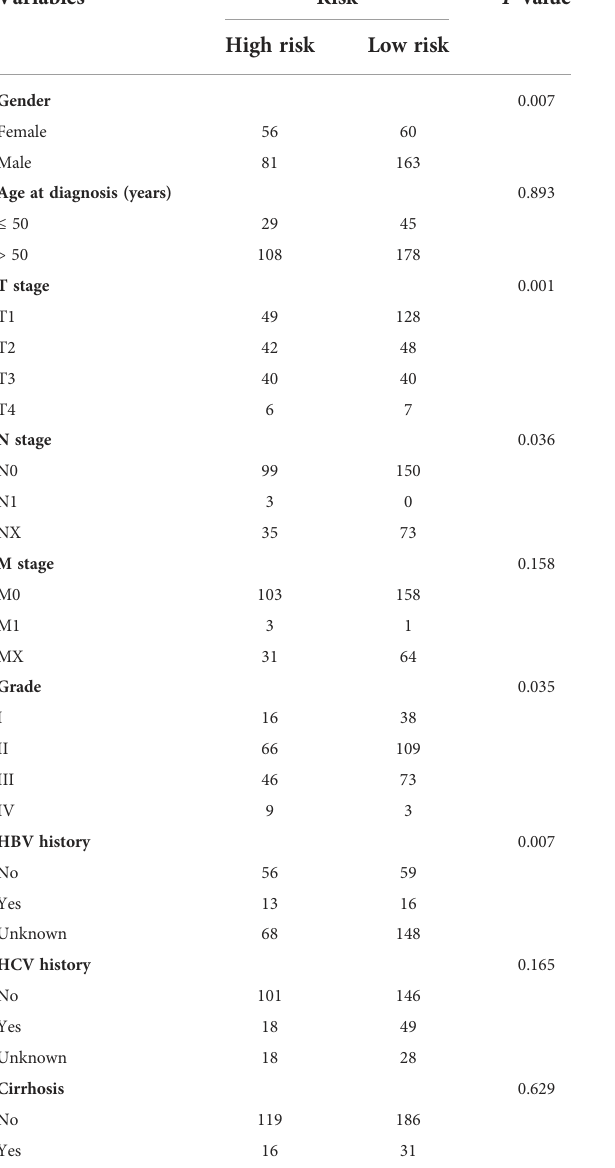
TABLE 1 Clinicopathologic characteristics of TCGA HCC patients according to the Tyrosine -related signature. Variables